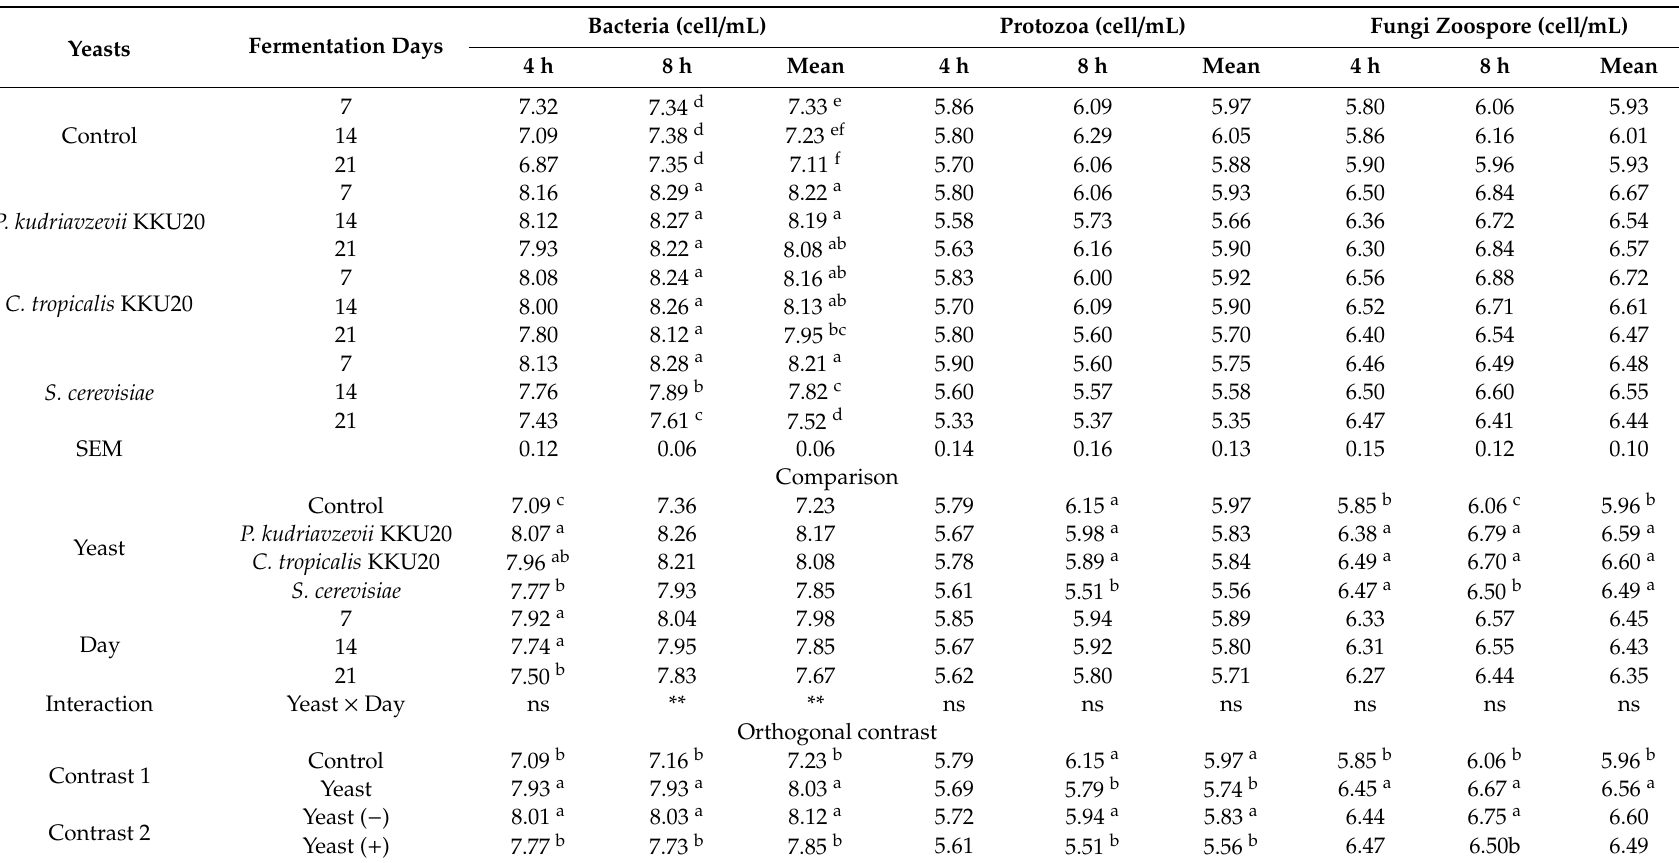
Table 6. Microbial populations in rumen fluids from rice straw fermented with Crabtree-negative and -positive yeasts from in vitro incubation.